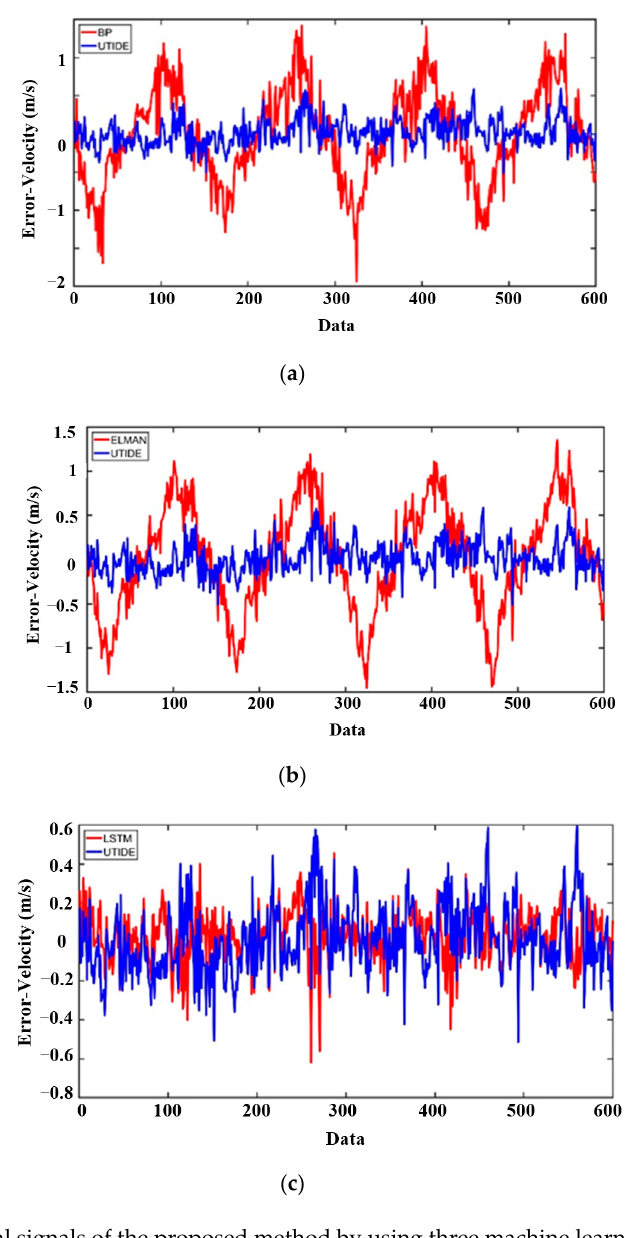
Figure 19. Residual signals of the proposed method by using three machine learning algorithms and UTide (30 m under sea surface). ( a ) Residual signals by using BP and UTide, ( b ) Residual signals by using ELMAN and UTide, ( c ) Residual signals by using LSTM and UTide.